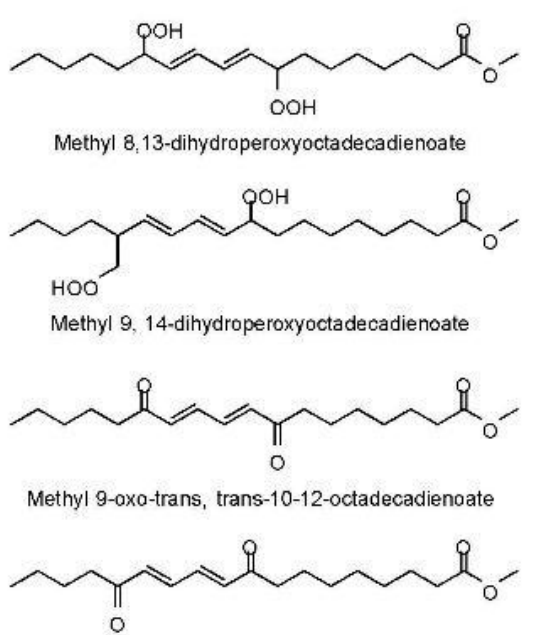
Figure 31. Oxidized products of methyl linoleate. Adopted, with permission, from [143]. Copyright 1983, Oil Chemists’ Society (AOCS). Table 22. 1 H-NMR chemical shifts and spin multiplicities of oxidation products of edible lipids. Adopted, with permission, from [26]. Copyright 2014, Institute of Food Technologists.